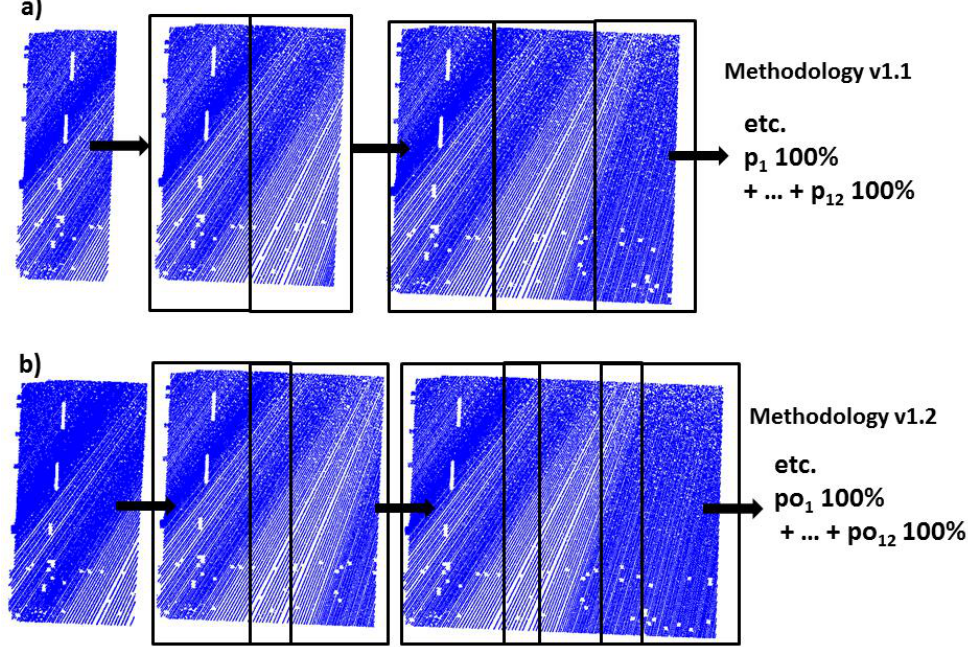
Figure 4. Scheme of test area division into strips ( a ) with and ( b ) without overlay.